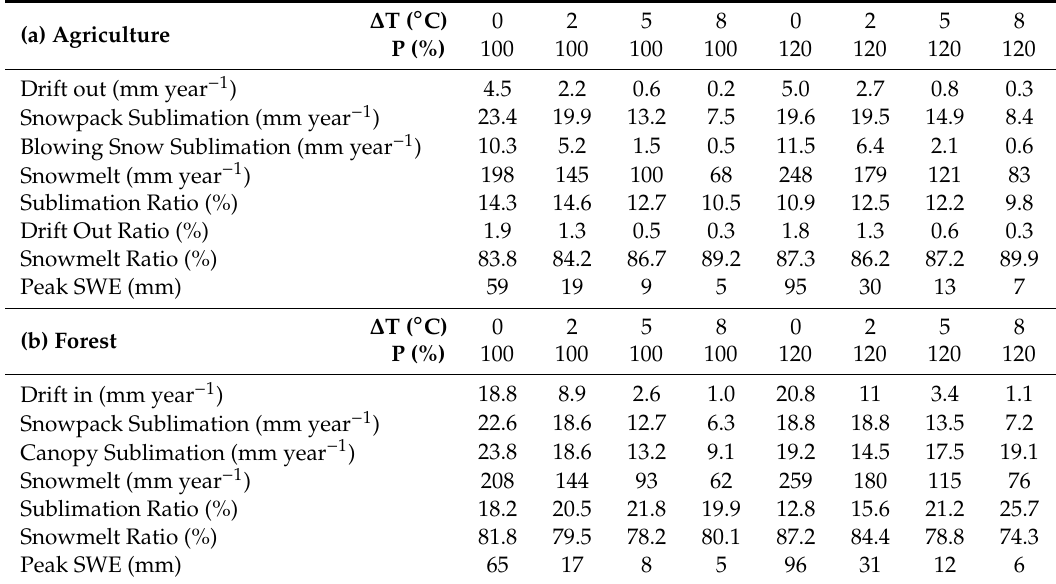
Table 3. Changes in magnitude of annual snow mass fluxes and resulting annual peak SWE in ( a ) agriculture and ( b ) forest under selected warming and increasing precipitation